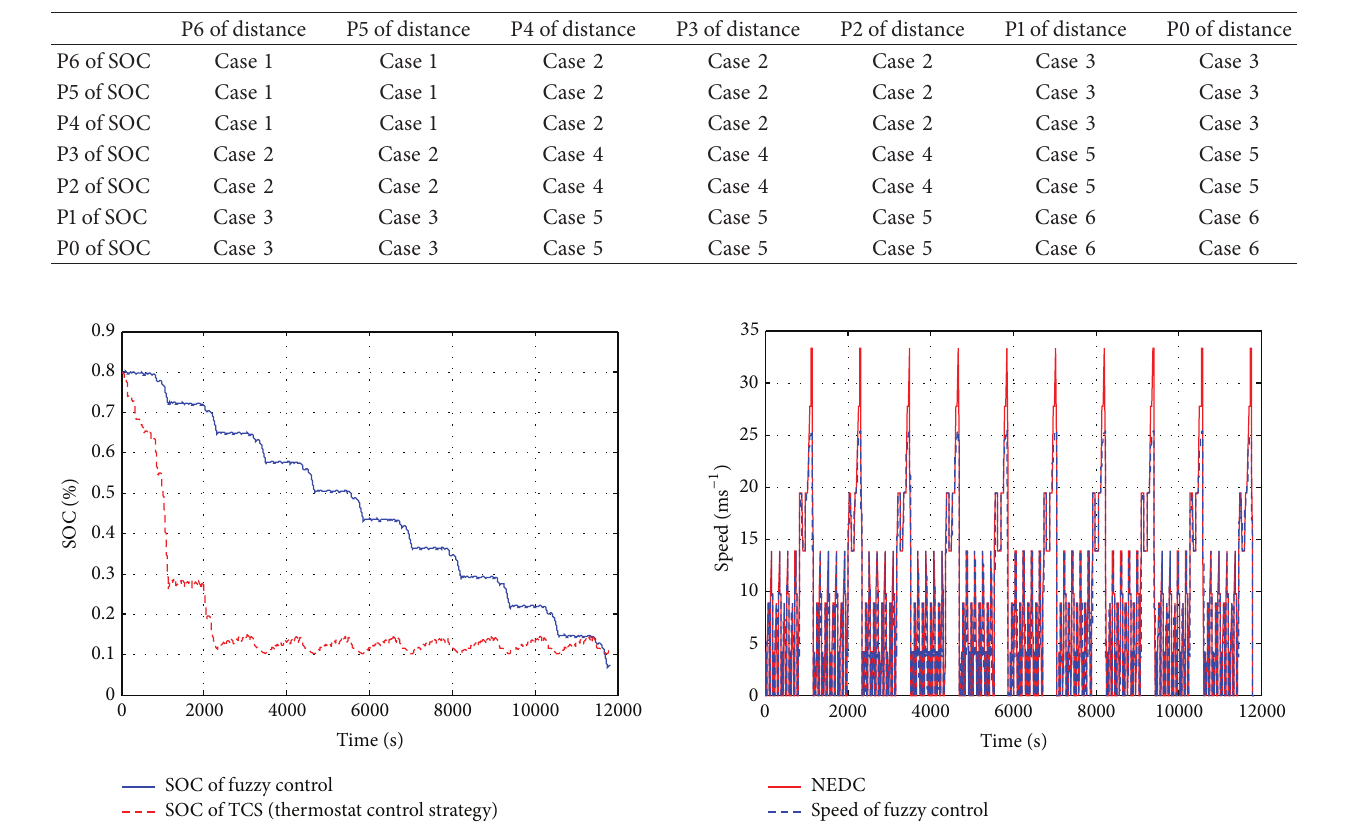
Table 1: Fuzzy rules.